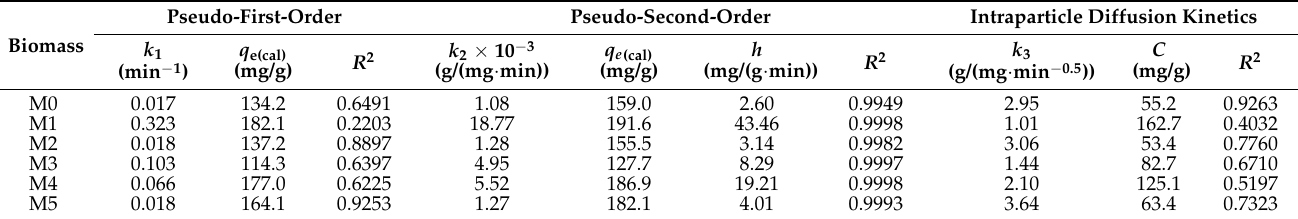
Figure 3. Uranium biosorption efficiency by the raw and chemically modified biomass of Deinococcus radiodurans ( a ), simulation of kinetics data of the raw and chemically modified biomass of Deinococcus radiodurans by the pseudo-first order-model ( b ), pseudo-second-order model ( c ), and intraparticle diffusion model ( d ). M0, unmodified biomass. M1, extraction of lipid. M2, modification of amino group. M3, modification of carboxyl group. M4, modification of phosphate group. M5, modification of hydroxyl group. Table 2. Calculated pseudo-first-order and pseudo-second-order model